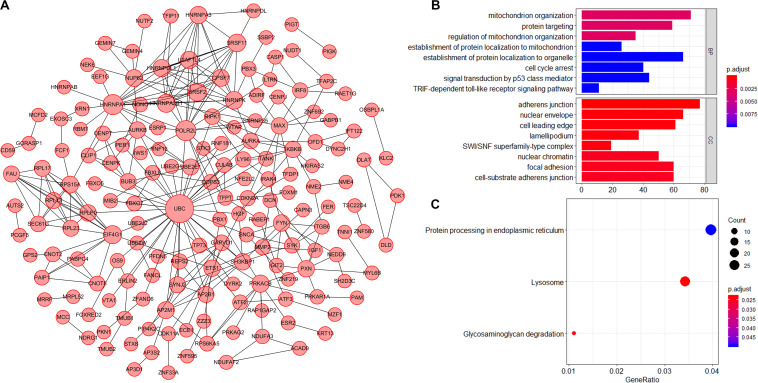
Molecular characteristics of genes with survival-associated AS events in CC. (A) Gene interaction network of genes with survival-associated AS events in CC generated by Cytoscape. Larger circles indicate greater importance. (B) GO analysis of genes with prognosis-related AS events. BP: Biological process; CC: Cellular component. (C) KEGG pathway analysis of genes with prognosis-related AS events.